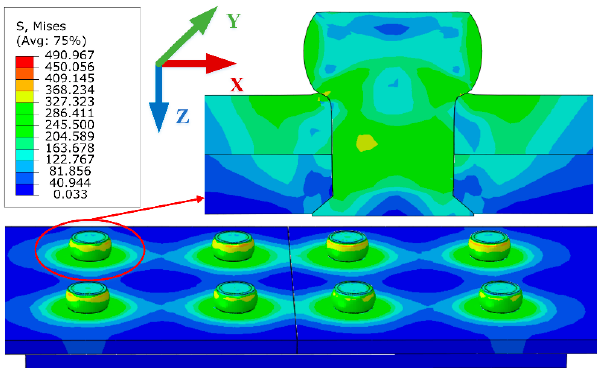
Figure 11. The Von Mises stress of the riveted butt joint after riveting (group 2-5-4).